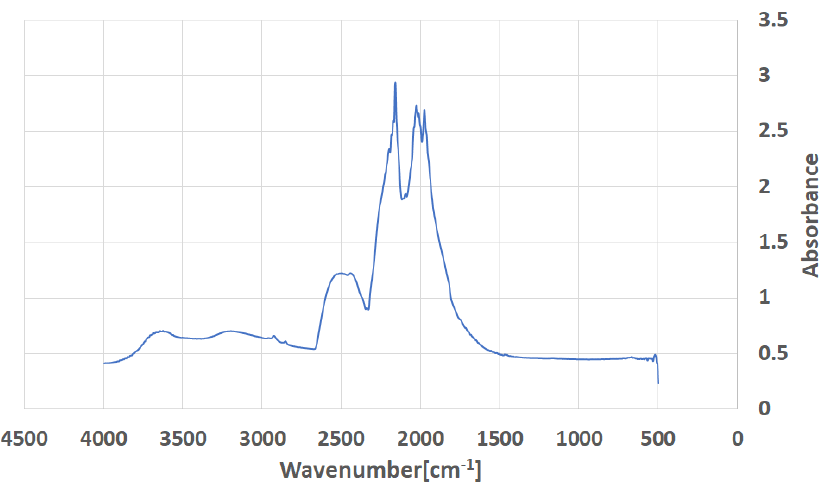
Figure 3. The infrared absorption spectra of the 2a master diamond. The absorption values at 1095 cm − 1 is 0.